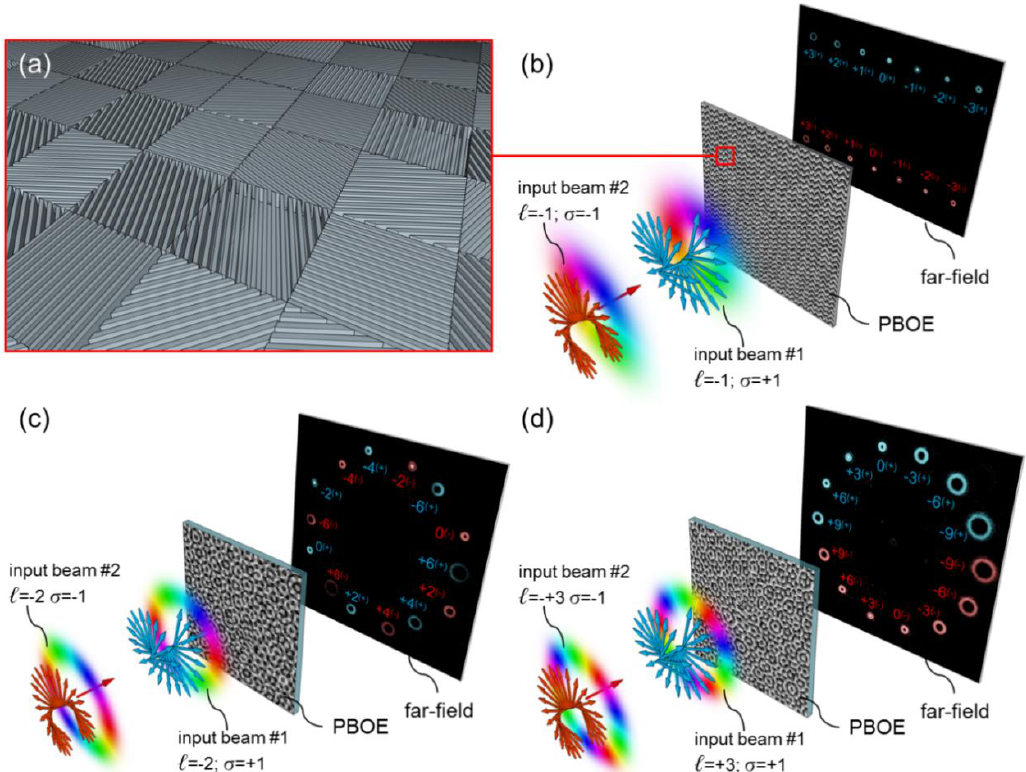
Figure 1. Scheme of the working principle of Pancharatnam–Berry optical elements (PBOEs)for orbital angular momentum (OAM) demultiplexing with the method of OAM-beam projection. If a circularly-polarized OAM-beam illuminates the optical element, a bright spot appears in the far field, at a position which depends on the polarization handedness and on the carried OAM. In the presented work, the PBOE has been fabricated in the form of a pixelated metasurface of rotated subwavelength gratings ( a ), and designed for the demultiplexing of 7 OAM channels and circular polarization states (14 channels in total) over different OAM sets, centered in ℓ = 0, with increasing OAM separation Δ ℓ = 1 ( b ), Δ ℓ = 2 ( c ), Δ ℓ = 3 ( d ). Three different channel configurations have been considered and tested: Linear array ( b ), regular polygon (heptagon) ( c ), semicircle ( d ).